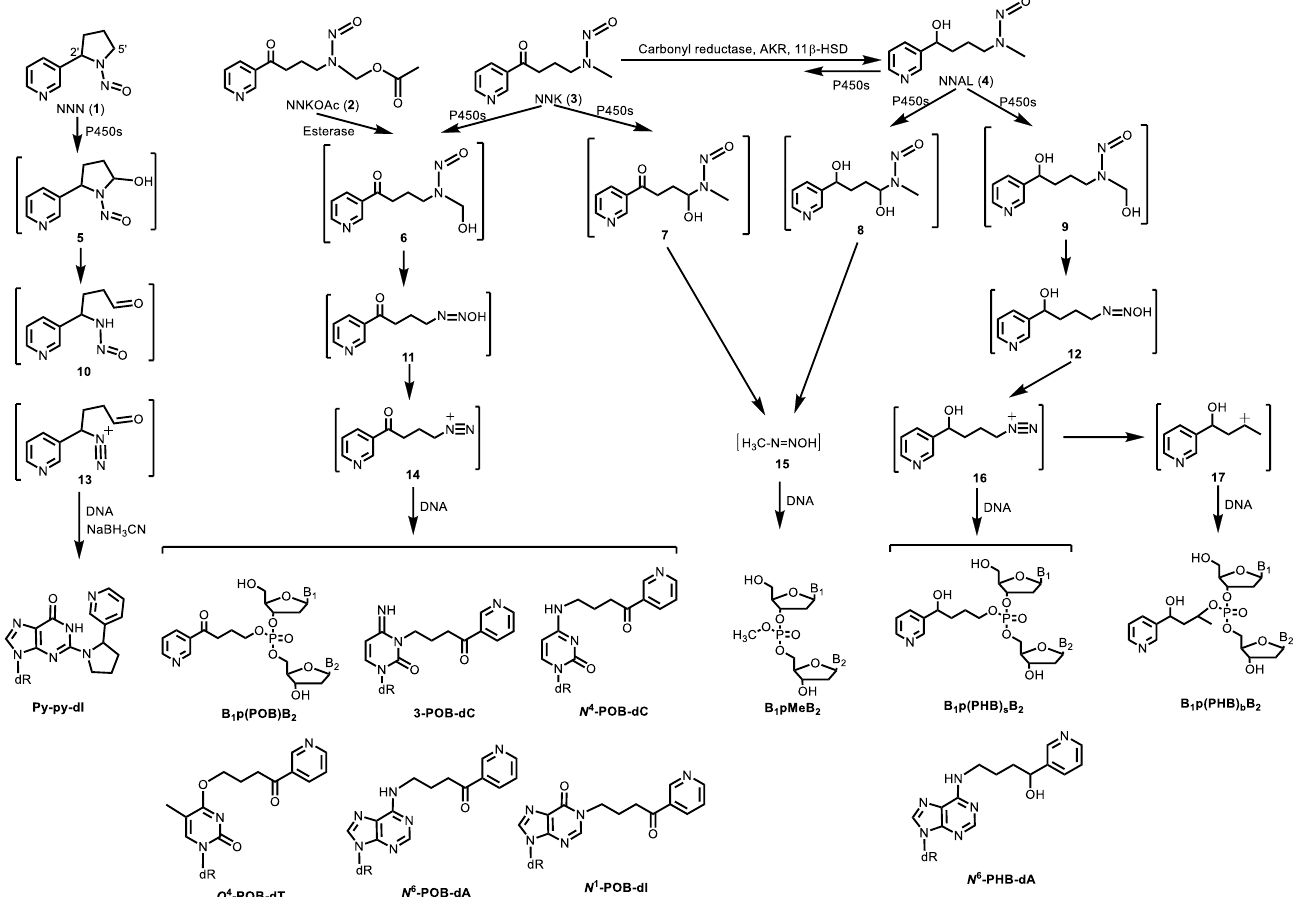
Figure 3. NNK and NNN-derived DNA base and phosphate adducts. NNK and NNN form various DNA adducts, and only newly characterized adducts or adducts detected for the first time in vivo since 2012 are presented. NNN is also metabolized via 2’ -hydroxylation to intermediate 14 , which reacts with DNA to form POB base adducts. B 1 and B 2 represent the same or different nucleobases. NNK, 4-(methylnitrosamino)-1-(3-pyridyl)-1-butanone; NNN, N ′ -nitrosonornicotine; POB, pyridyloxobutyl; dR, 2′ -deoxyribose.